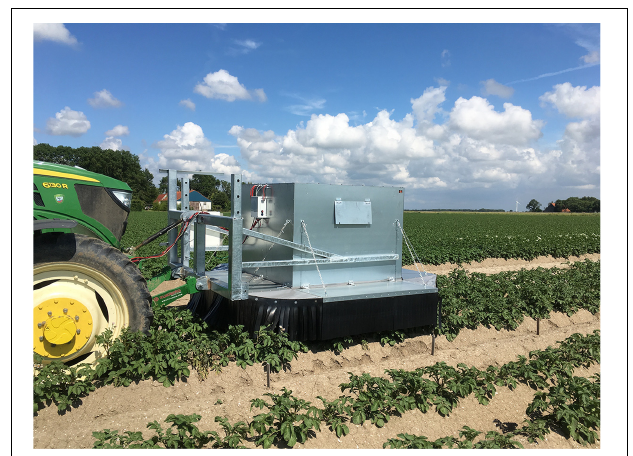
FIGURE 3 | Picture of the system while doing field measurements.